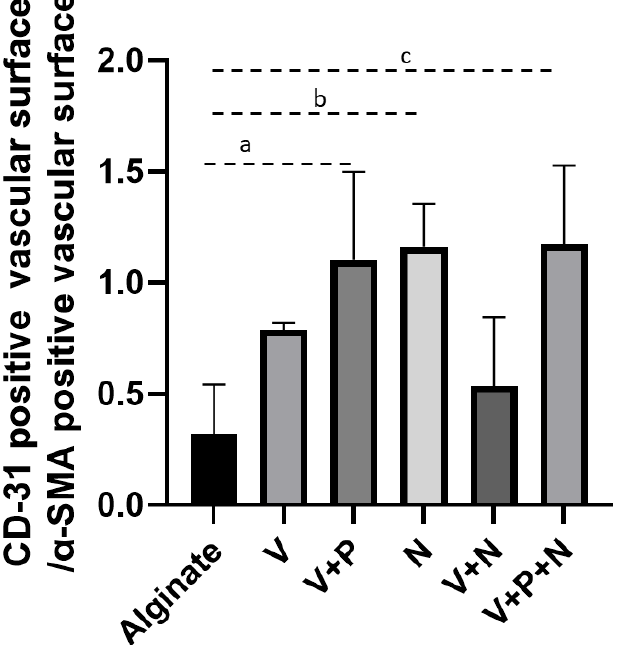
Figure 7. Impact of NP supplementation on neo-vascularization stabilization. The CD-31/α-SMA ratio was calculated for grafts retrieved after 21 days a: p = 0.04; b: p = 0.02; c: p = 0.02. n = 18.